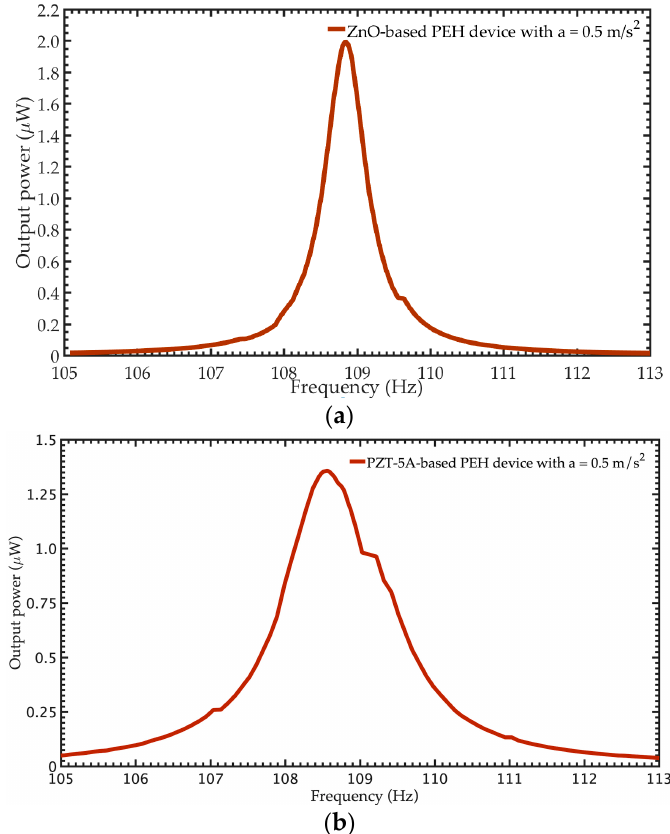
Figure 9. Generated power with respect to the frequency of the PEH devices with ZnO ( a ) and PZT-5A ( b ) layers.